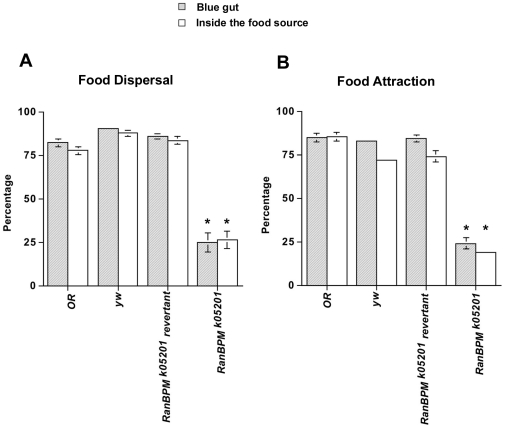

RanBPMK05201 mutants feed less and are not attracted to food.Batches of 25 3rd instar foraging larvae were starved for 2 hours and then placed inside (A, Food Dispersal) or outside the food (B, Food Attraction) laced with blue dye for 1.5 hours. The proportion of larvae that were in the food was determined at the end of the assay. All larvae were examined for the presence of blue matter in the gut indicative of food intake. RanBPMk05201mutants when placed inside the food in the beginning of the assay ingest food significantly less than control larvae (A shaded bars, x2 = 94.68, DF = 3, p = 0.0001) and are found immersed in the food in a significantly smaller number than control (A empty bars, x2 = 83.31 DF = 3, p = 0001). Similarly, when placed outside the food plug RanBPMk05201 mutants feed significantly less (B shaded bars, x2 = 120.89, DF = 3,) and are attracted to the food less (B empty bars x2 = 121.09 DF = 3) when compared to control larvae. In all experiments * p<0.0001, N>100.